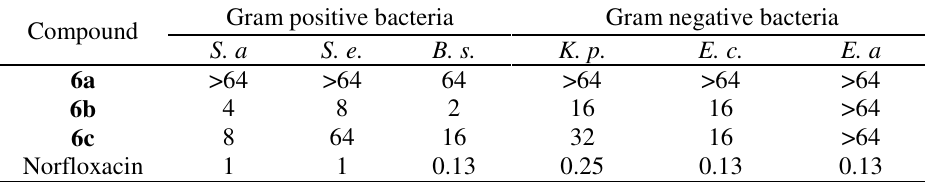
Table 1. In vitro antibacterial activities of compounds 6a-c against selected bacteria a